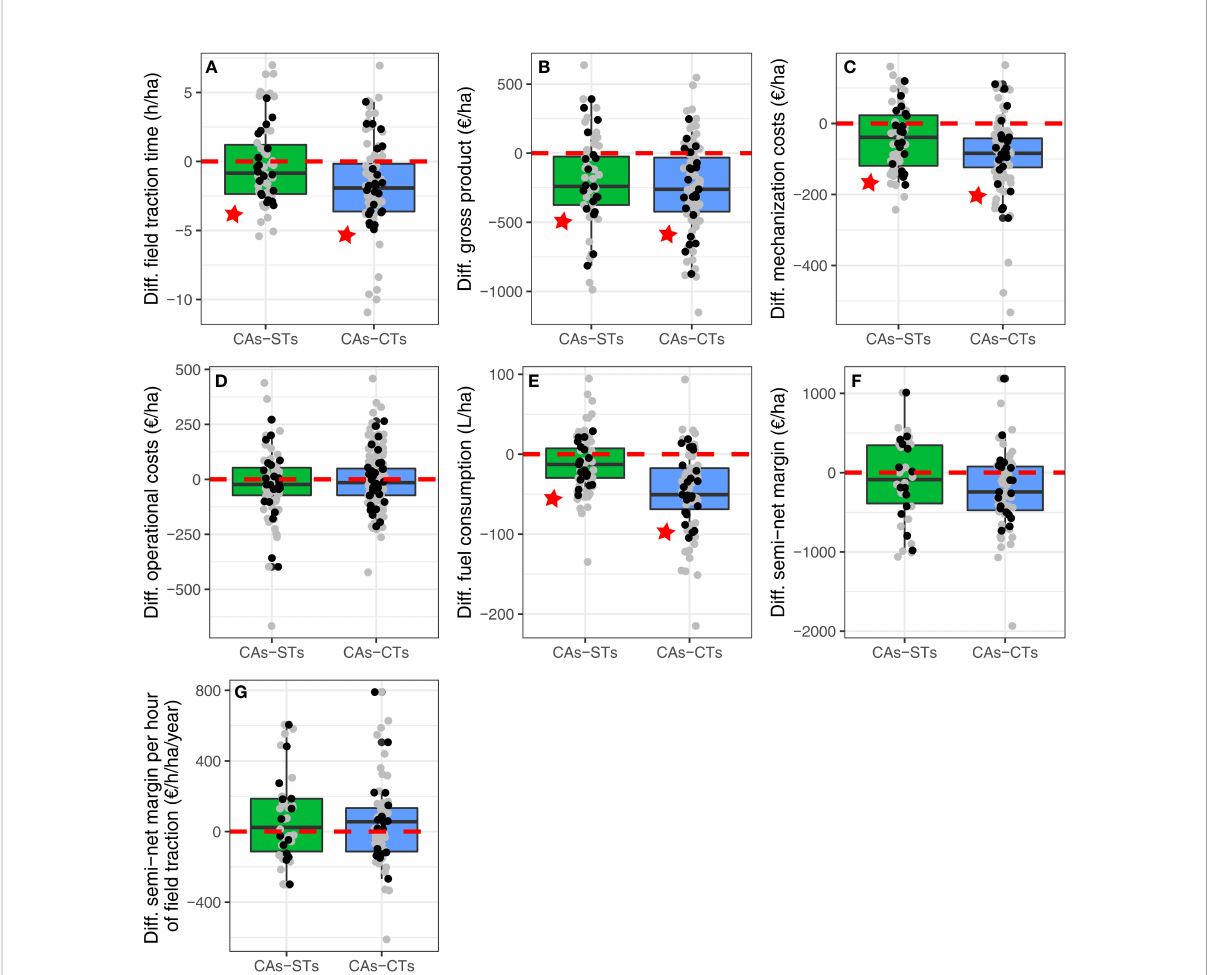
FIGURE 4 Technical and economic performances of conservation agriculture systems (CAs). Distributions of the differences in response variables between CAs and their reference conventional tillage (CTs, blue boxplots) and super fi cial tillage (STs, green boxplots) based systems for mechanized work time (h/ha/year, A ), gross product ( € /ha/year, B ), mechanization costs ( € /ha/year, C ), operating costs ( € /ha/year, D ), fuel consumption (L/ha/ year, E ), semi-net margin ( € /ha/year, F ) and semi-net margin per hour of fi eld traction ( € /h/ha/year, G ). Grey dots represent individual differences between systems. Black dots represent average differences per cluster. Red stars indicate signi fi cant differences between CAs and its reference system (either CTs or STs) at p<0.05. Cluster was included as a random effect in the statistical models to account for production situation effects (see details in Table